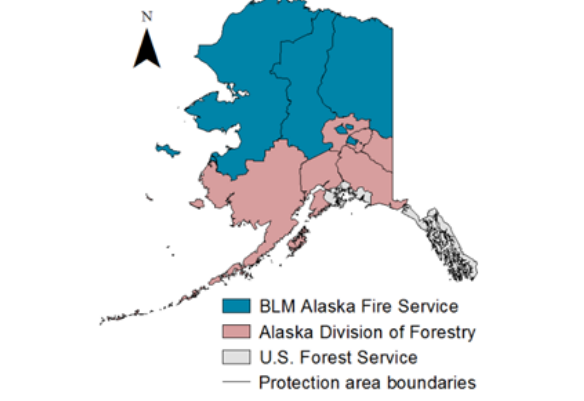
Forest Service. Lines within shaded sections delineate administrative divisions for each protection